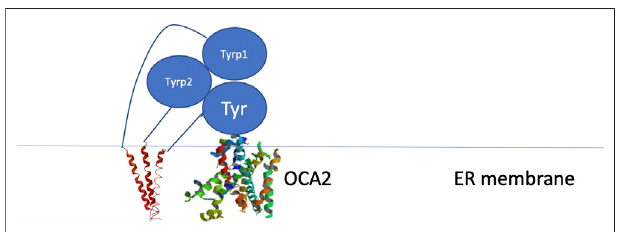
FIGURE 6 | Schematic representation of the proposed site of binding between the melanogenic complex and a binding partner such as